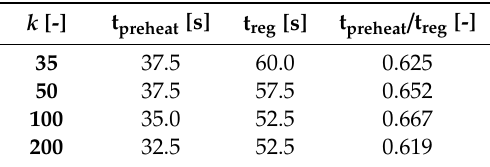
Table 4. Time for preheating, t preheat , time for filter regeneration, t reg , and t preheat / t reg ratio, as calculated at T in = T in_optimal for di ff erent values of k .